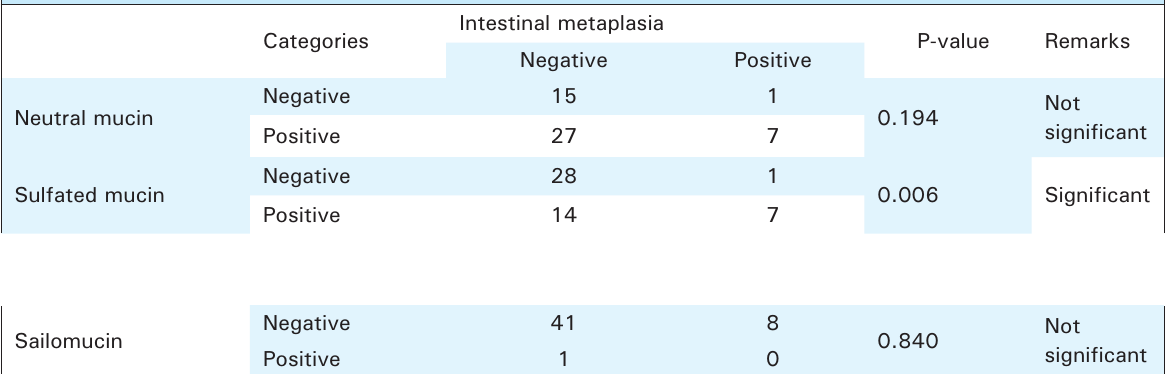
Table 4. Crosstabulations between mucins with intestinal metaplasia in gallbladder. Intestinal Categories